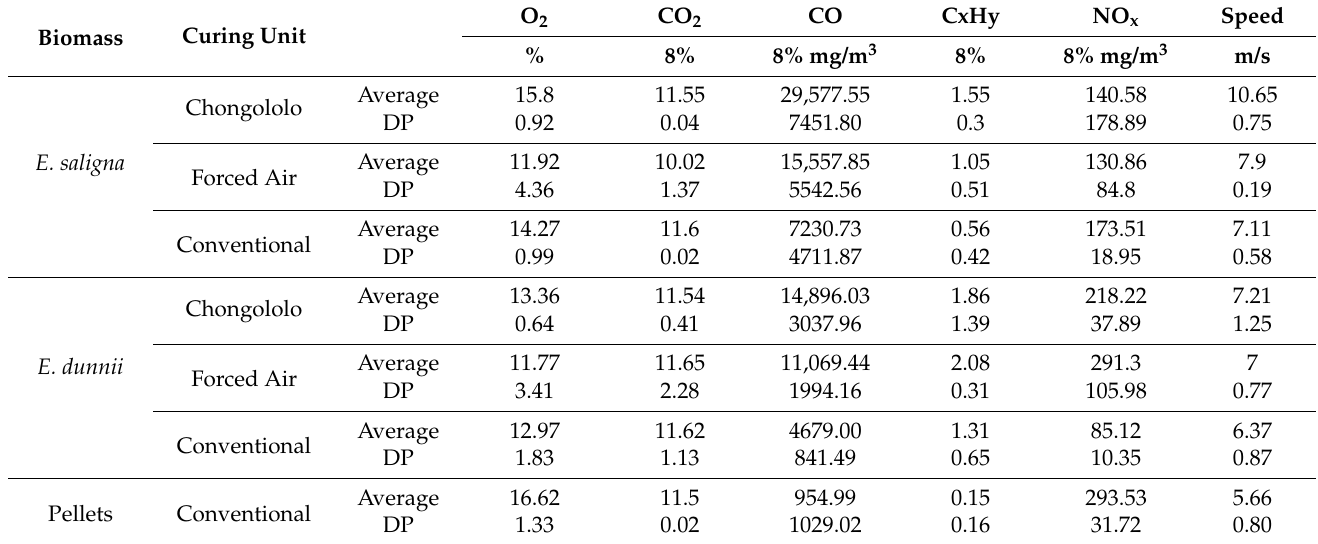
Table A2. Oxygen as a reference.